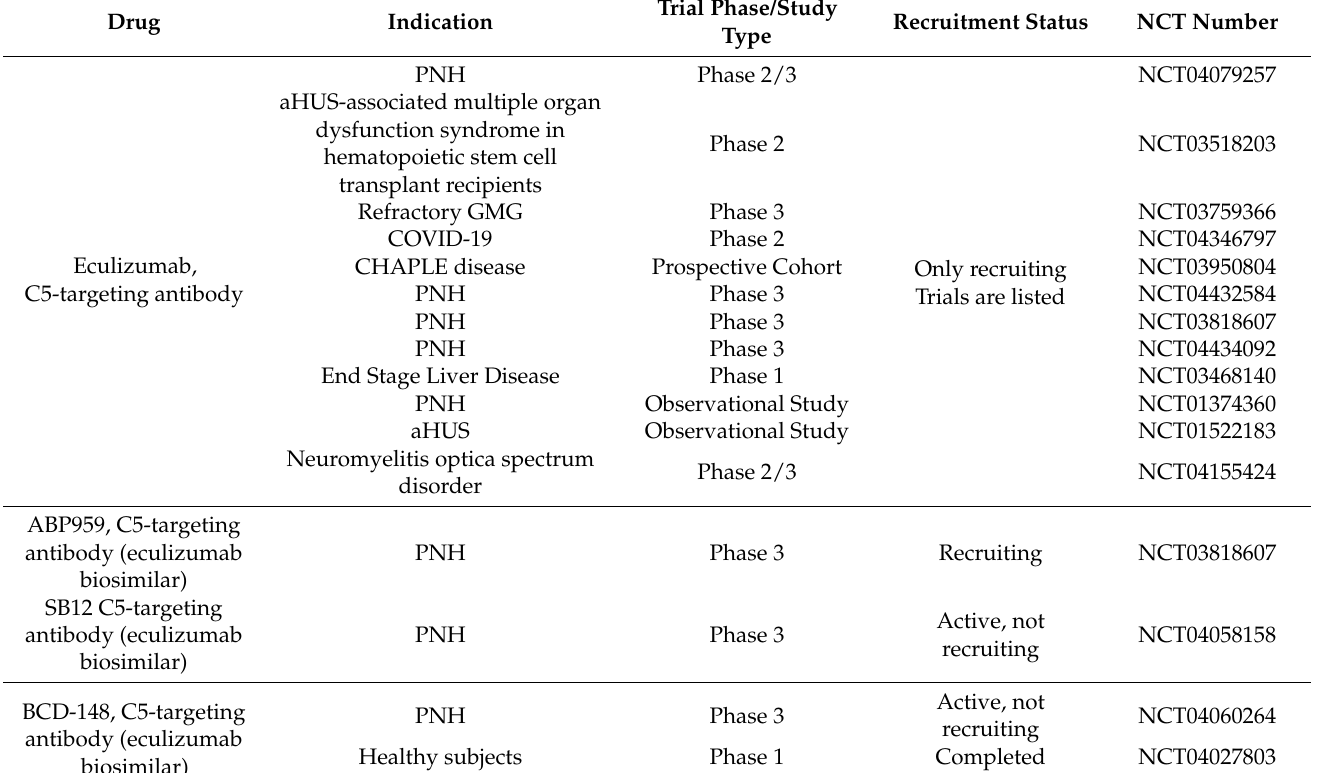
Table 1. List of compounds under development targeting the complement